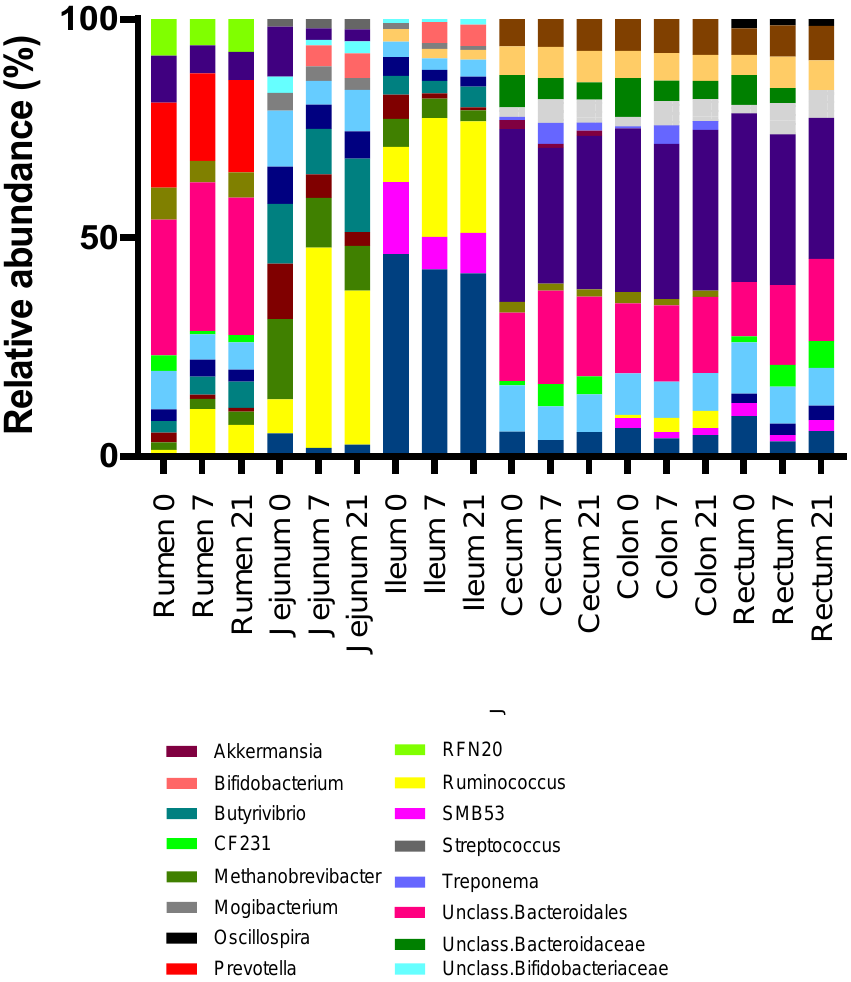
unidentified Ruminococcaceae, unidentified Clostridiales, and unidentified Coriobacteriaceae, whereas those of Ruminococcus , Bifidobacterium , Methanobrevibacter , Prevotella, and Butyrivibrio increased during this period. Of those that decreased between D0 and D21, the relative abundances of unidentified Clostridiales, unidentified Peptostreptococcaceae, unidentified Bifidobacteriaceae, unidentified Lachnospiraceae increased between D7 and D21, whereas that of unidentified Coriobacteriaceae continued to decrease between D7 and D21. Of Desulfovibrionaceae genera that increased their Figure 5. Effect of the duration of feeding a moderate grain diet (0, 7, or 21 d) and region of the abundances between D0 and D7, the relative abundance of Ruminococcus decreased between D7 and digestive tract on the relative abundances of abundant phyla. D21, whereas those of Bifidobacterium and Methanobrevibacter continued to increase during that period.